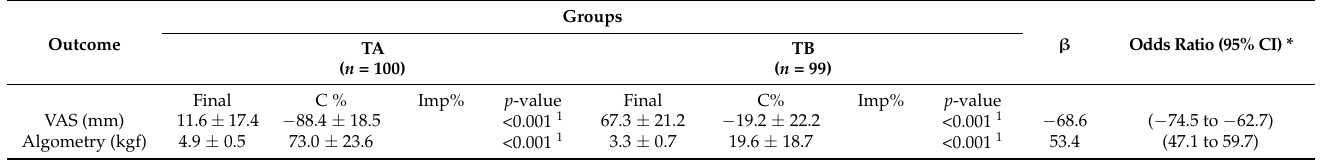
Table 2. Outcomes at final